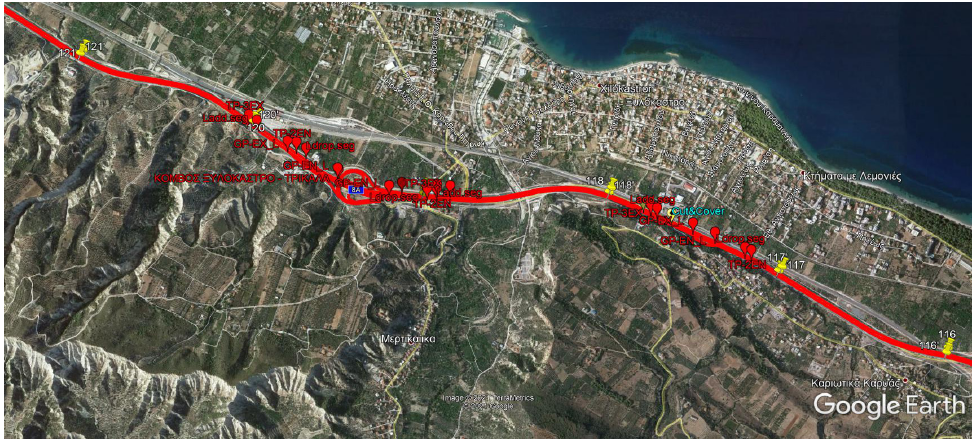
Figure 2. Extract of the Google Earth .kmz file.